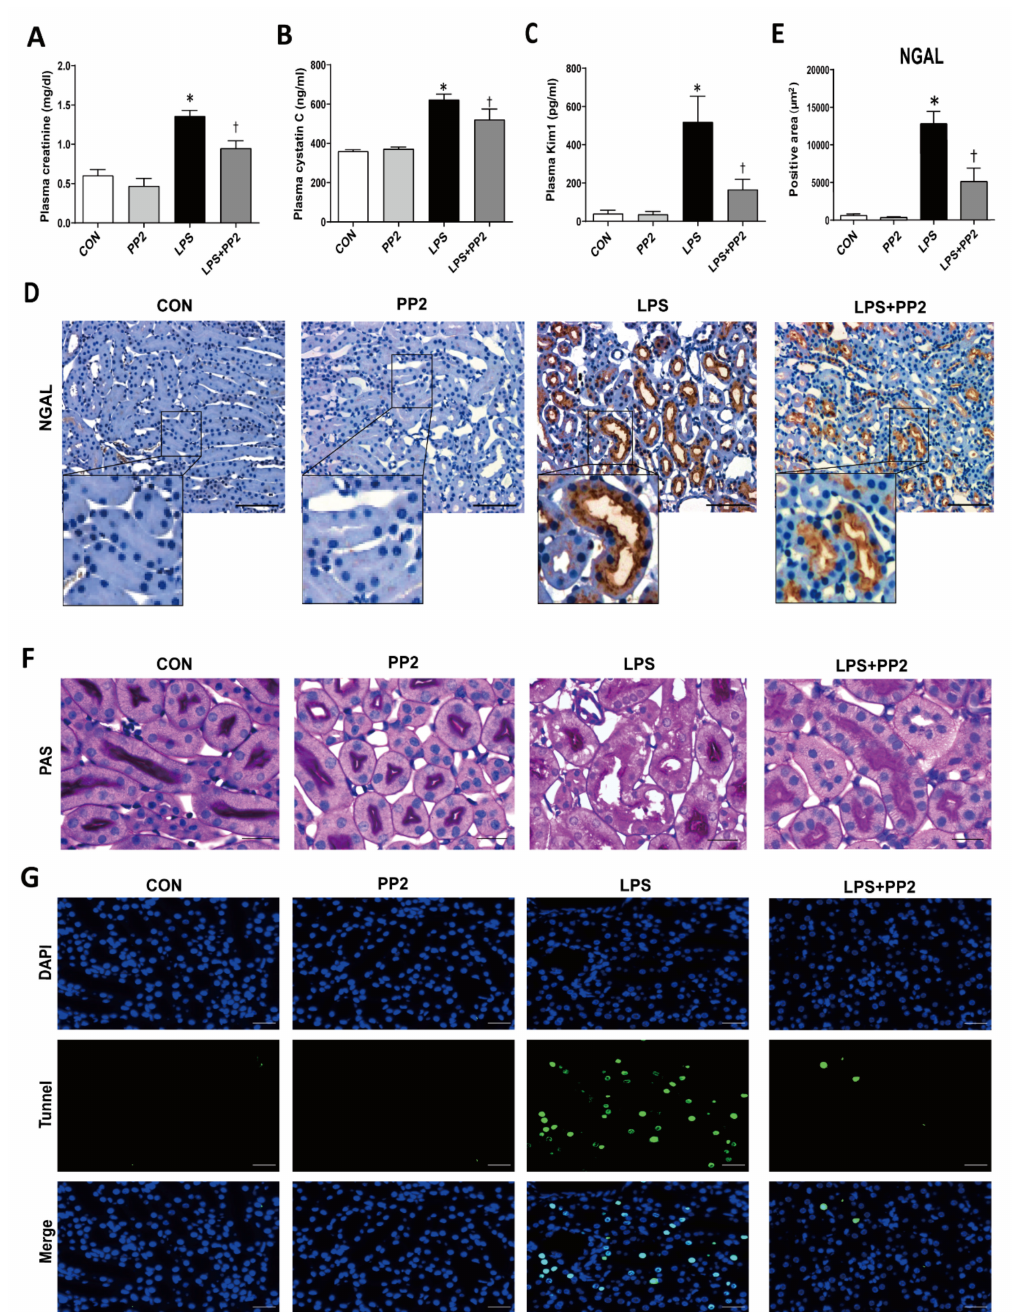
Figure 2. PP2 improves kidney function and attenuates kidney tubular injury in LPS-induced acute kidney injury (AKI) mice. Blood plasma was analyzed for ( A ) plasma creatinine (mg / dL), ( B ) plasma cystatin C (ng / mL), and ( C ) tubular injury marker, plasma Kim1 (pg / mL). Para ffi n-embedded kidney sections were stained with ( D , E ) NGAL antibody (1:200; original magnification: 200 × ; scale bar: 100 µ m: enlarged images have been shown in inset) and ( F ) PAS staining (original magnification: 630 × ; scale bar: 20 µ m). ( G ) Apoptosis was measured in kidney sections using the terminal deoxynucleotidyl transferase-mediated dUTP nick end-labeling (TUNEL) assay (original magnification: 400 × ; scale bar: 100 µ m). Data are presented as mean ± SE of 6–8 mice. * p < 0.05 vs. control, † p < 0.05 vs.